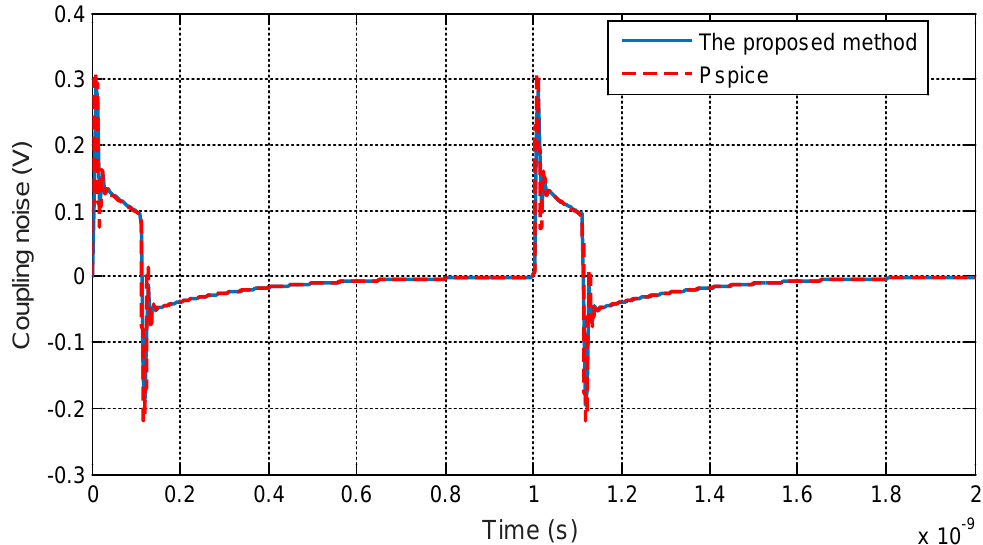
Figure 13. The proposed method and Pspice simulation of the TSV – TSV coupling noise with uncoupled RDLs ( l RDL = 200 µm) at port 4.